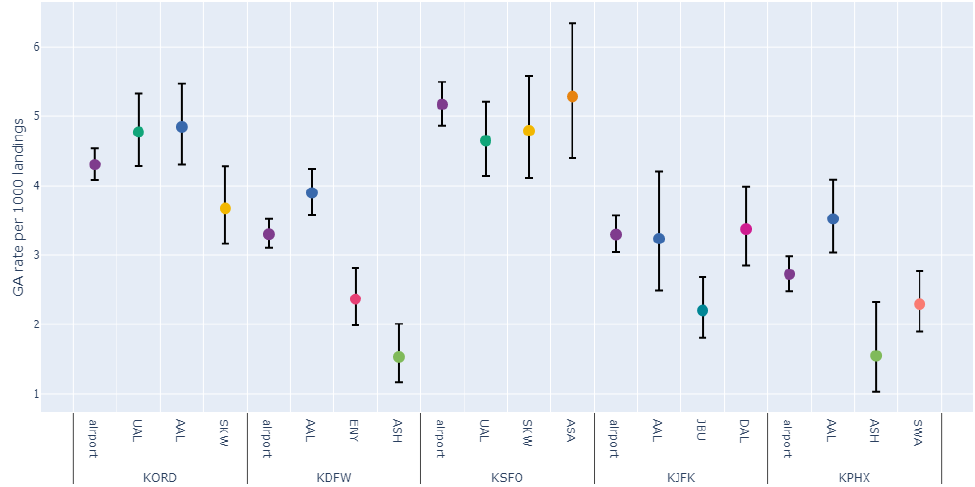
Figure 3. GA rates, per 1000 landings, of the top three operators at selected US